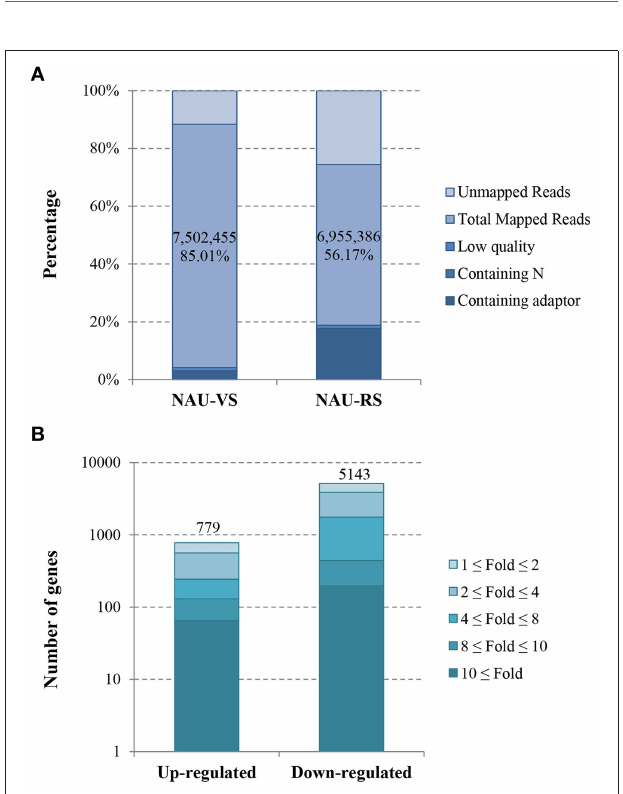
FIGURE 1 | Overview of the sequencing and mapping (A) and the identified DEGs (B) in NAU-VS and NAU-RS libraries.